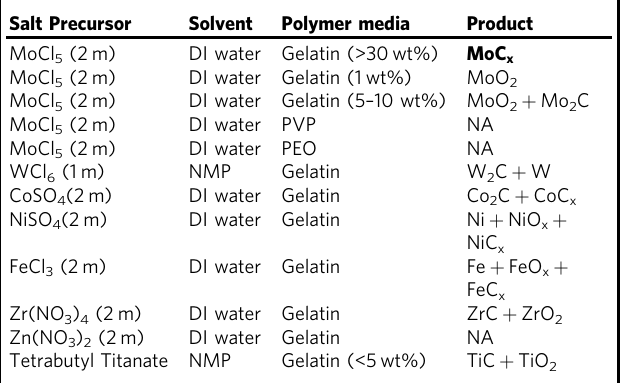
Table 1 Summary of the composition of various hydrogels and their obtained products with laser